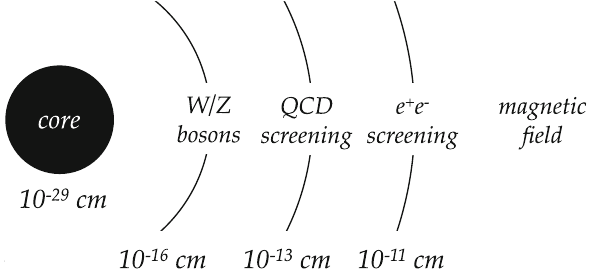
Fig. 33 Structure of a GUT monopole with virtual gauge bosons pop- ulating the outer spheres (after Ref.